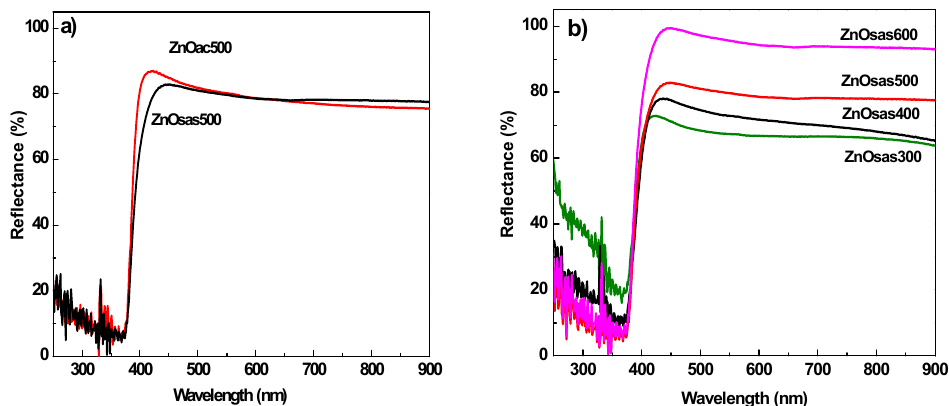
Figure 6. UV-Vis diffuse reflectance spectra of ( a ) zinc oxide (ZnO) from supercritical antisolvent (SAS) zinc acetate (ZnAc) nanoparticles calcined at 500 °C and ZnO from unprocessed ZnAc calcined at 500 °C; ( b ) ZnO from SAS ZnAc nanoparticles calcined at 300, 400, 500, and 600 °C.